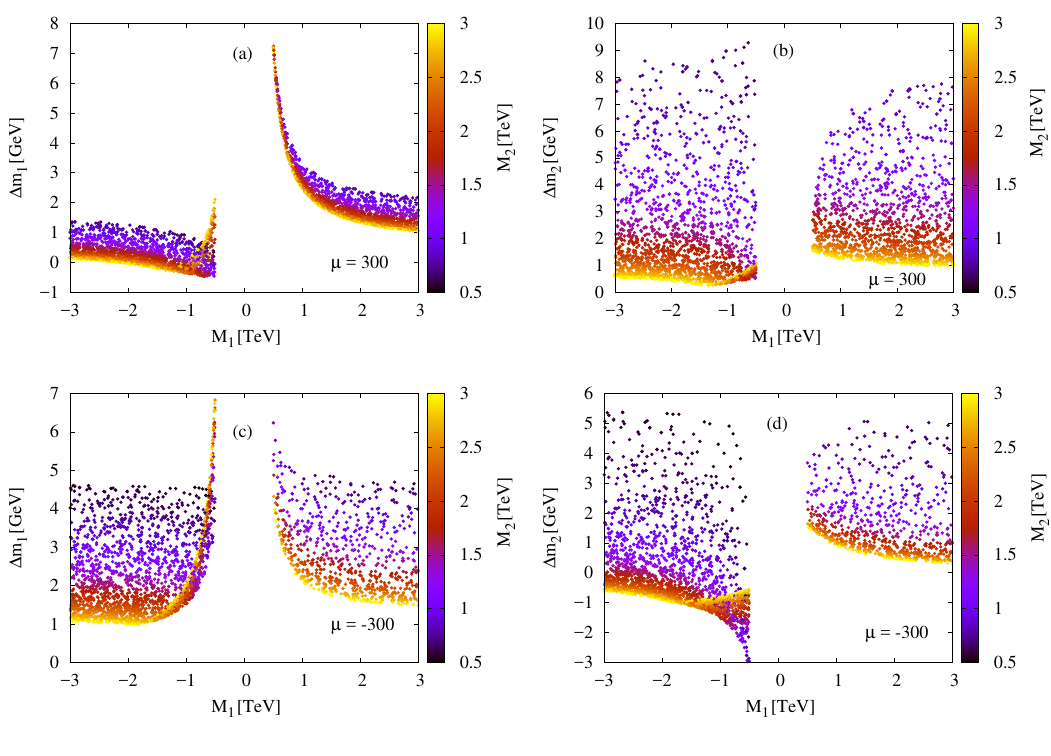
Figure 2 . The left (right) panel shows the variation of the mass di(cid:11)erence (cid:1) m 1 = m m ((cid:1) m 2 = m e (cid:31) 0 1 the